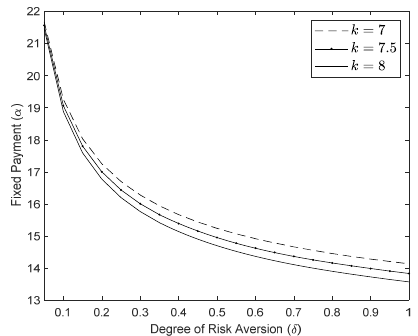
Fig. 3. The effect of degree of risk aversion on the fixed payment